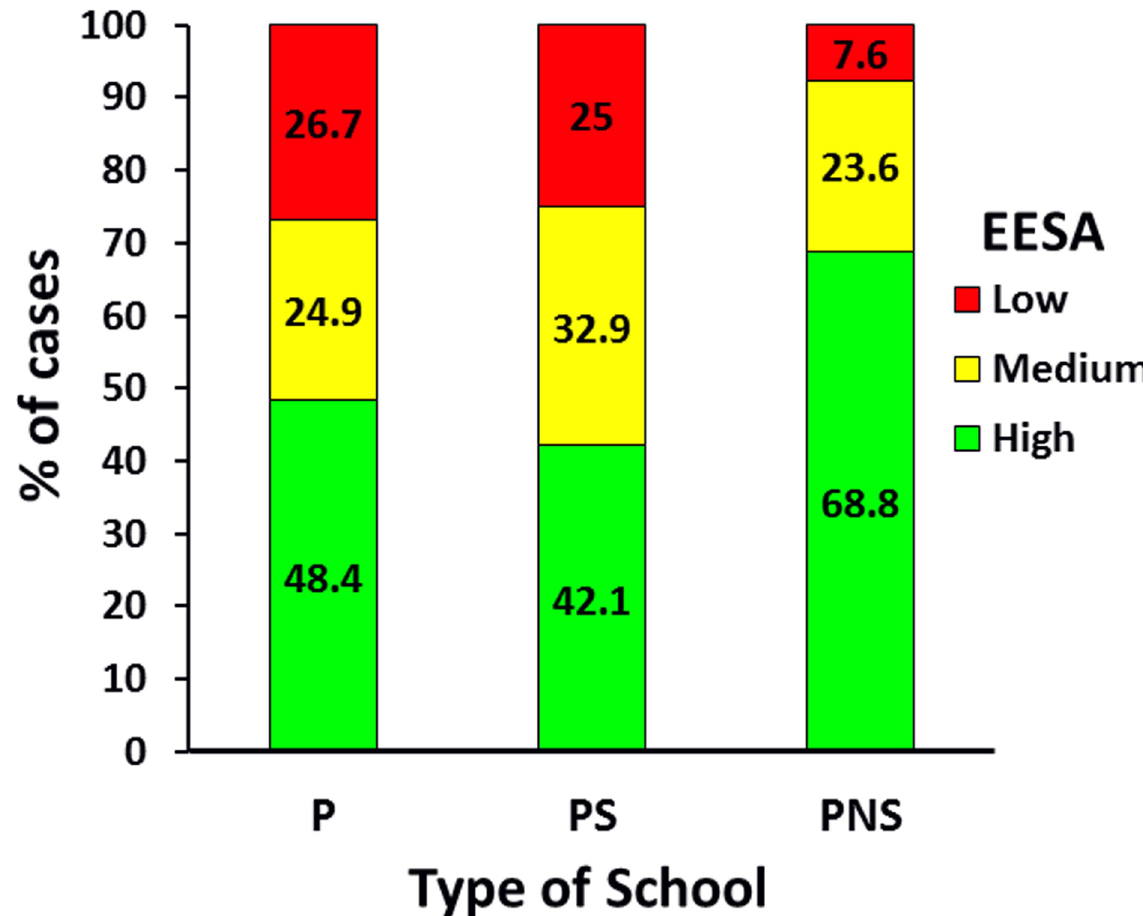
Fig 2. Distribution of the sample by the level of scholastic achievement of the educational establishments (EESA) in the 2009 SIMCE tests and type of school. Note . P = public schools; PS = private subsidized schools; PNS = private non-subsidized schools. ( n = 1,353). X 2 o (4df) = 36.381 > X 2 (4df) p < .001 = t